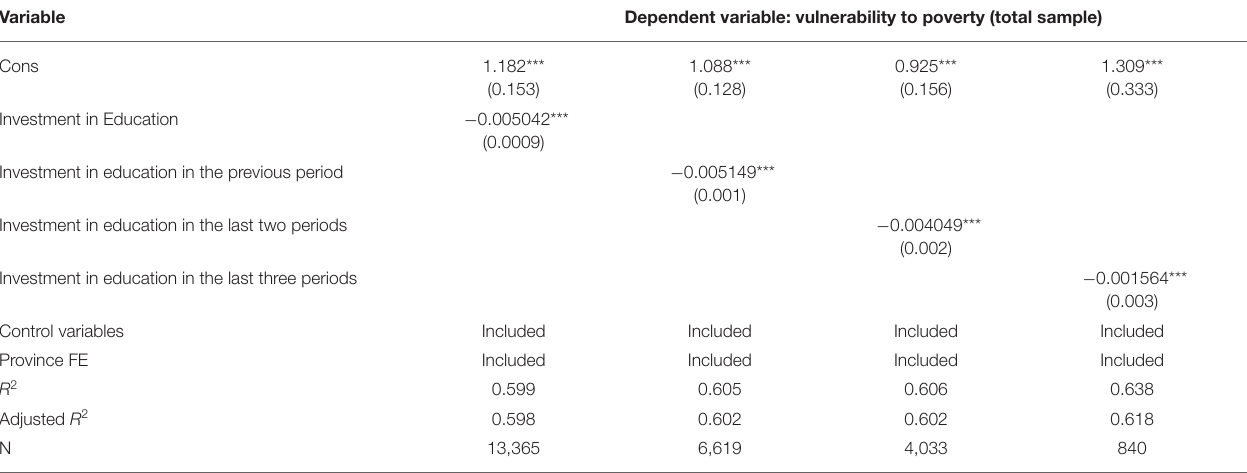
TABLE 11 | Test results of the effect of education investment on vulnerability to poverty.